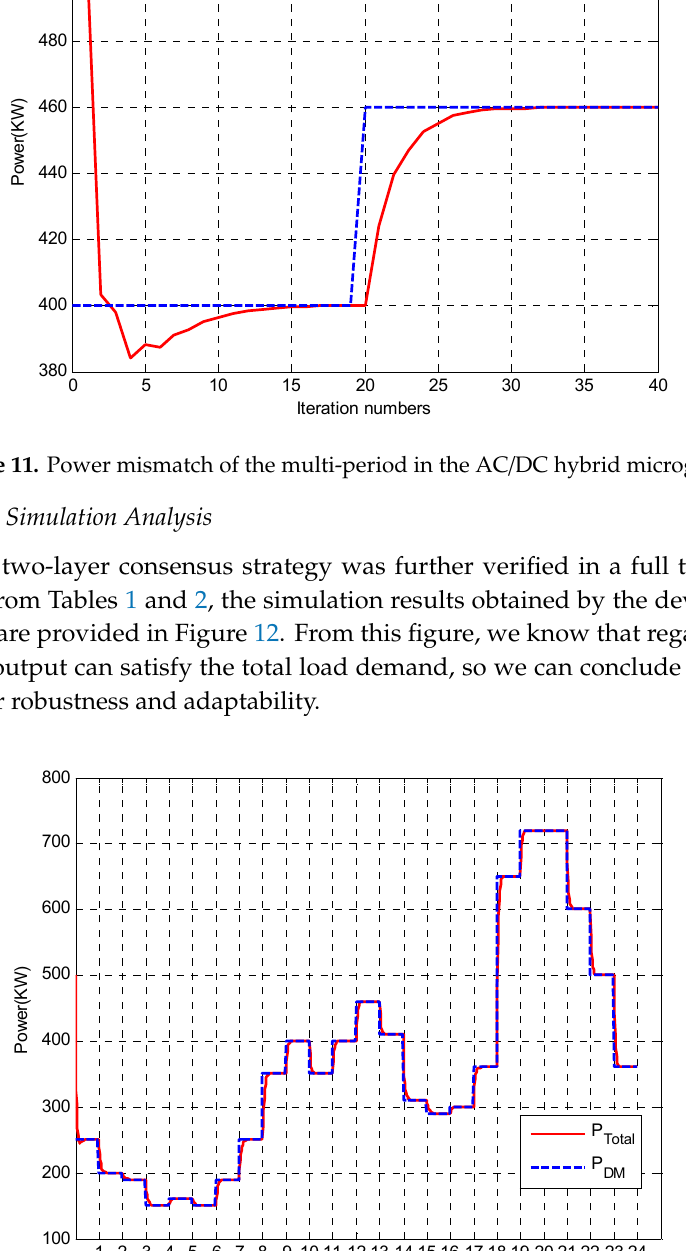
Figure 12. Power mismatch of the full time period (24 h) in the AC/DC hybrid microgrid.